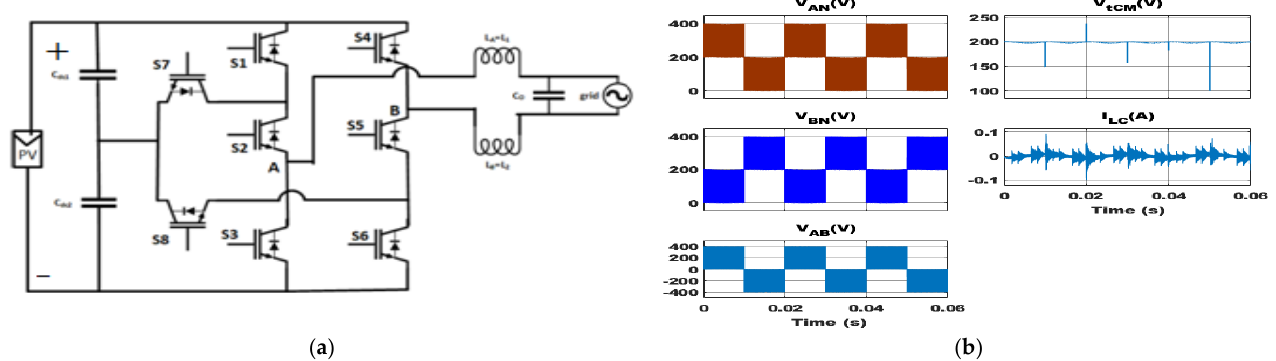
Figure 14. PN-NPC topology: ( a ) circuit structure; ( b ) simulation results.